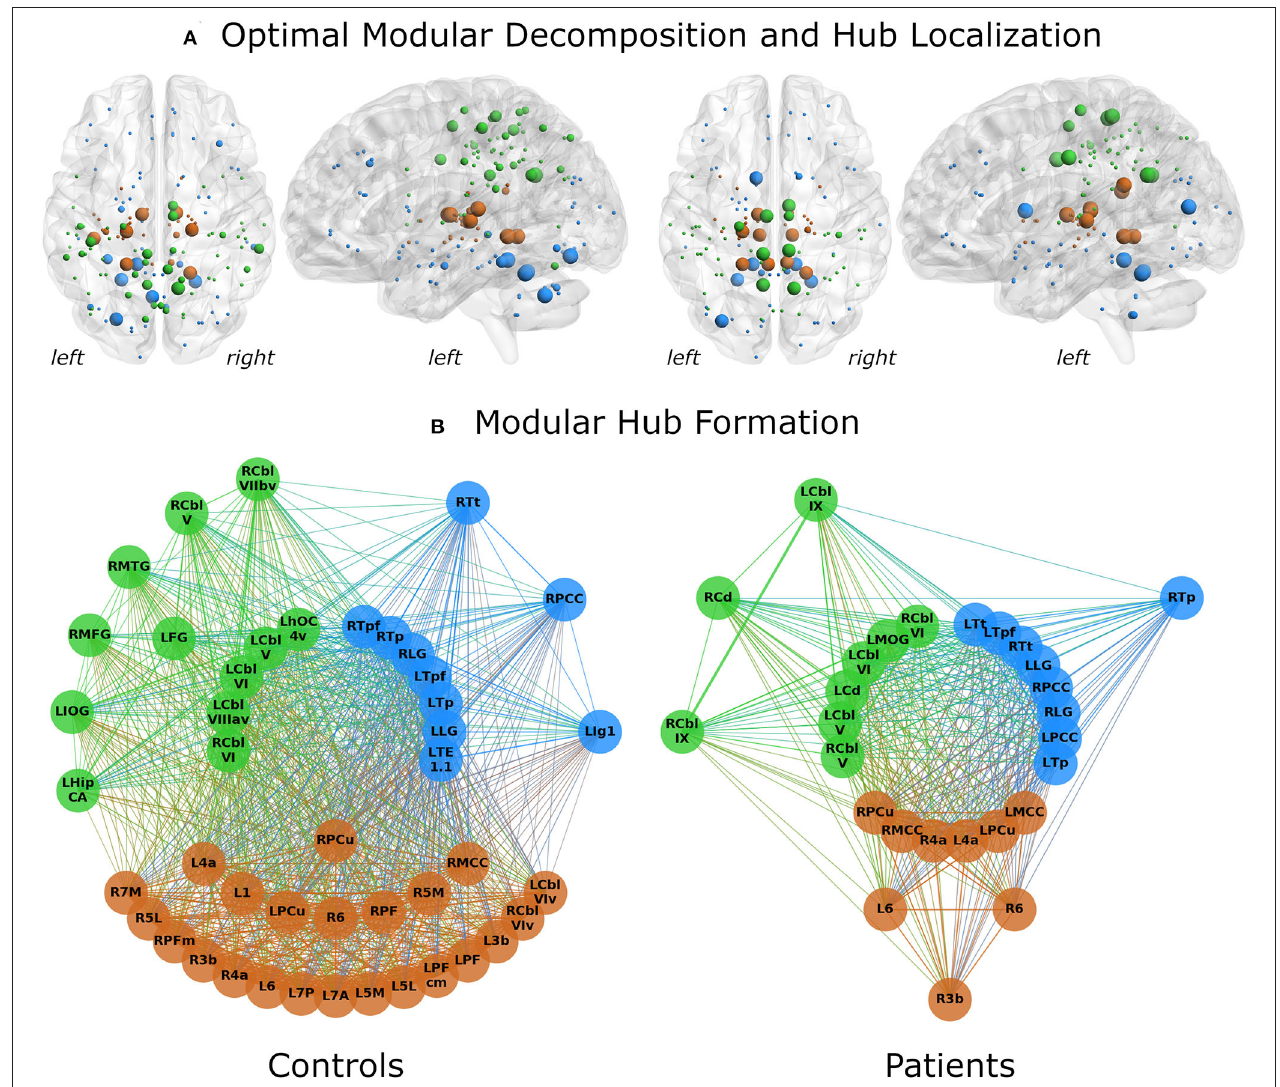
FIGURE 1 | Network analysis results for control subjects (left) and patients (right). (A) The optimal modular decomposition is shown by colored nodes in a 3D glass brain. Both groups had three modules: a fronto-occipital module (blue), a parietal module (green) and a subcortical module (brown). The size of each node indicates its hub status, from largest to smallest: connector hubs, provincial hubs, high influence nodes, other nodes. In both groups, hub formation was mostly restricted to the posterior part of the brain. (B) Hubs per module. All regions that were either hubs or high influence nodes are presented as colored nodes. Color illustrated module affiliation (as in A ). Nodes are arranged in three circles according to their hub status: connector hubs (innermost circle), provincial hubs (intermediate circle) and high influence nodes (outer circle). Controls recruited nearly the same number of hubs as patients, but these hubs communicated with more high influence nodes. 1/3b/6, BAs 1/3b/6; 4a, anterior part of BA 4; 5L/5M, subdivisions of BA 5; 7A/7M/7P, subdivisions of BA 7; Cbl V/VI/VIv/VIIbv/VIIIav/IX, cerebellar lobules V/VI/VI vermis/VIIb vermis/VIIIa vermis/IX; Cd, caudate nucleus; FG, fusiform gyrus; HipCA, subdivision of the hippocampus; hOC4v, ventral part of area hOC4; IOG/MOG, inferior/middle occipital gyrus; lg1, insular subdivision lg1; LG, lingual gyrus; MCC/PCC, middle/posterior cingulate cortex; MFG, middle frontal gyrus; MTG, middle temporal gyrus; PCu, precuneus; PF/PFcm/PFm, areas PF/PFcm/PFm in the inferior parietal cortex; TE1.1, area TE1.1; Tp/Tpf/Tt, parietal/prefrontal/temporal subdivision of the thalamus; L, left; R,